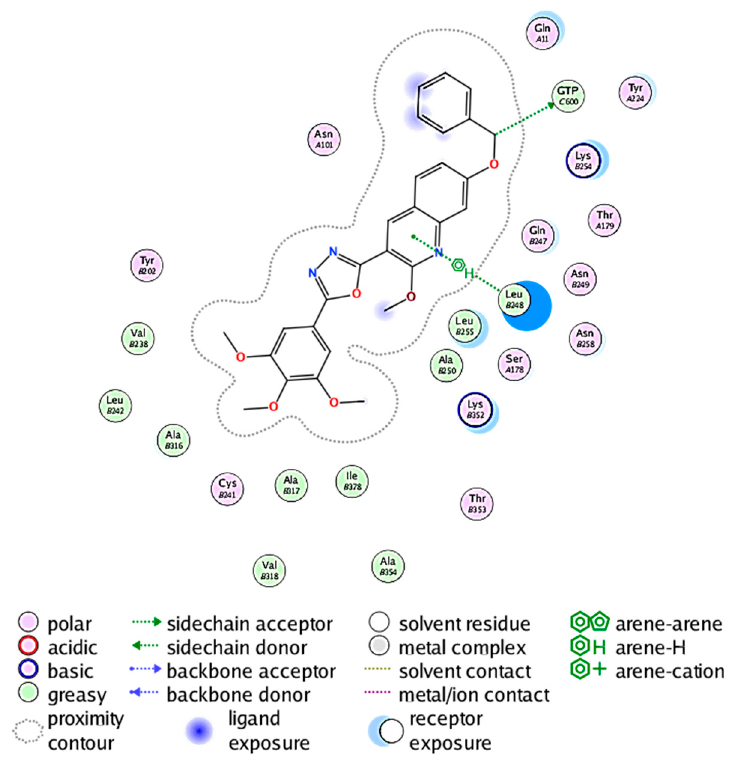
Figure 10. 2D Ligand Interaction Schematic for 20j as generated by MOE.